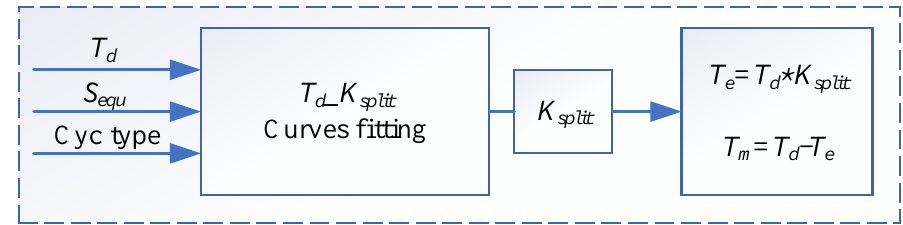
Figure 10. Online optimization flow